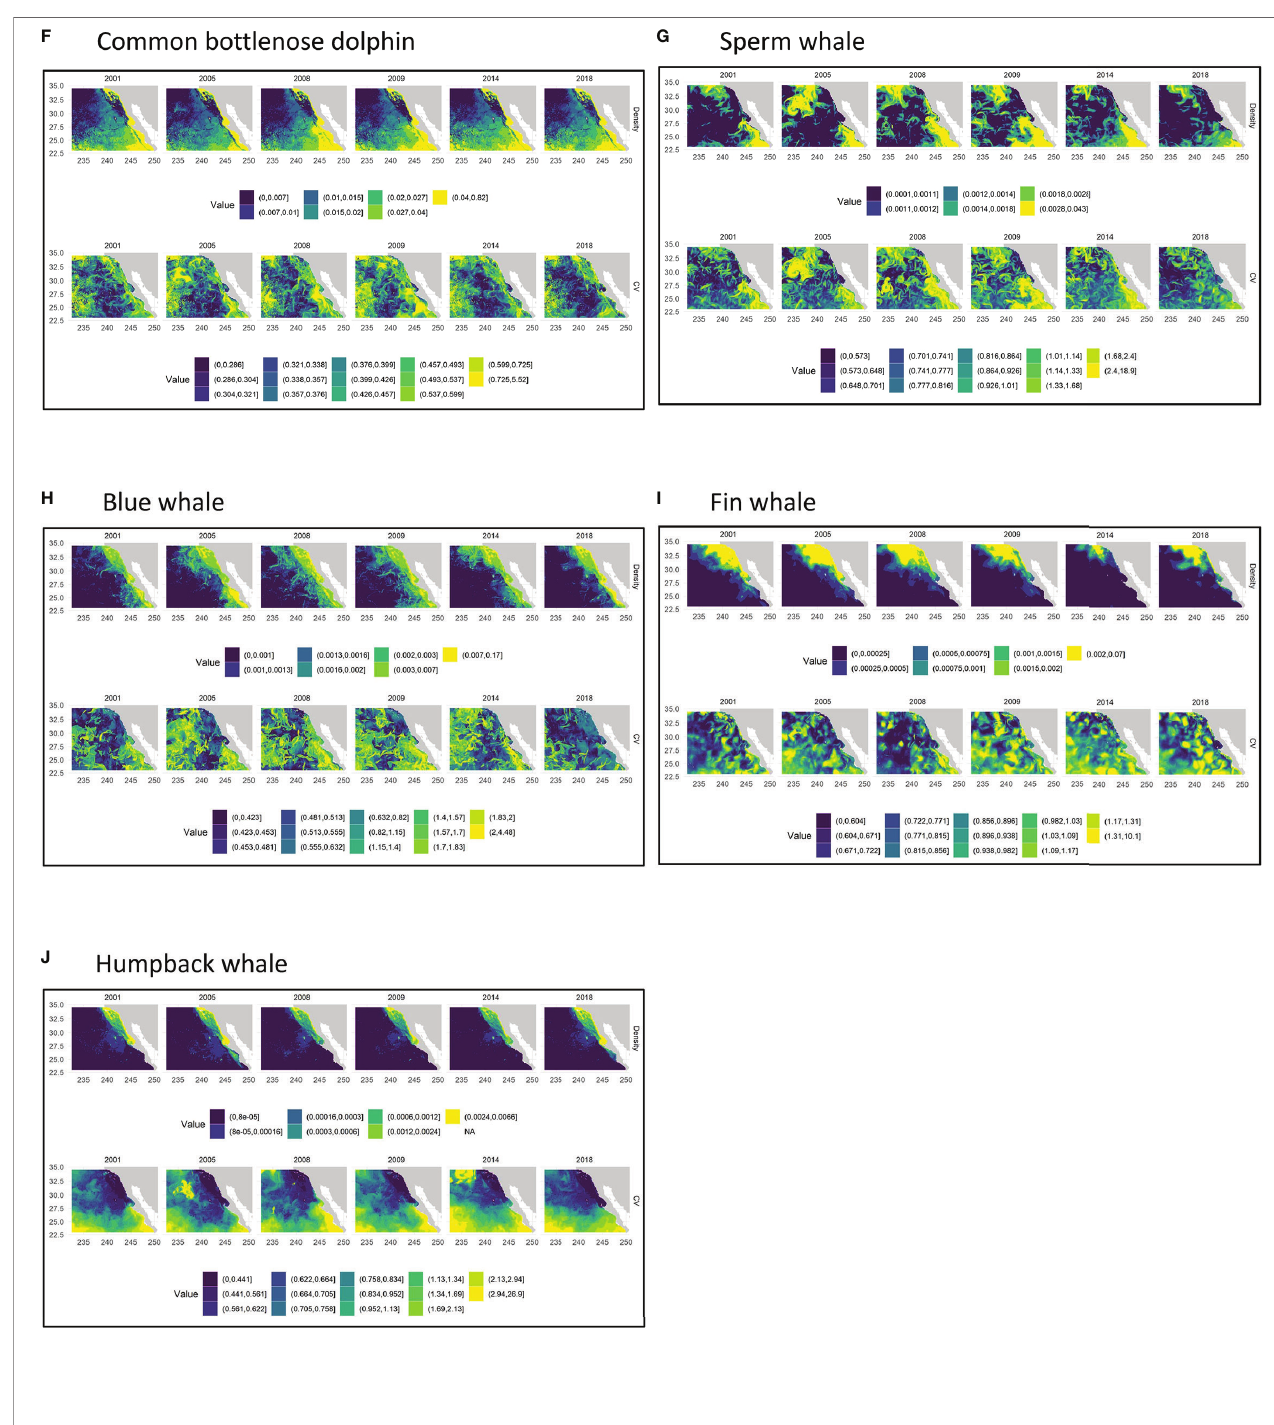
FIGURE 4 | Predicted yearly (2001-2018) mean densities and uncertainty estimates from the 1992 – 2018 habitat-based density models for (A) long-beaked common dolphin, (B) short-beaked common dolphin, (C) Risso ’ s dolphin, (D) Paci fi c white-sided dolphin, (E) striped dolphin, (F) common bottlenose dolphin, (G) sperm whale, (H) blue whale, (I) fi n whale, and (J) humpback whale. Panels show the yearly average density based on predicted daily cetacean species densities covering August- November of the respective years, as well as the coef fi cients of variation of density (CV). The range of values represented by each color are shown to the right of the color block. Density ranges are the same as those used for the 1992 – 2018 average density estimates shown in Figure 3